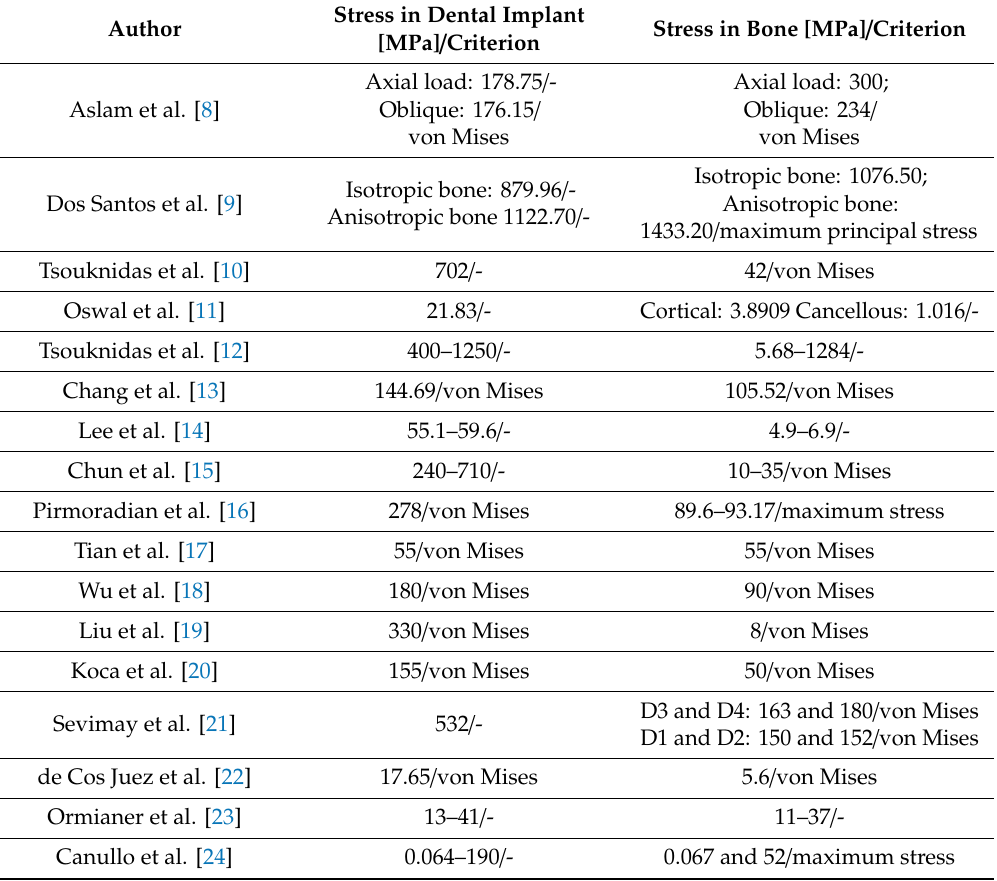
Table 4. Stress on bone and dental